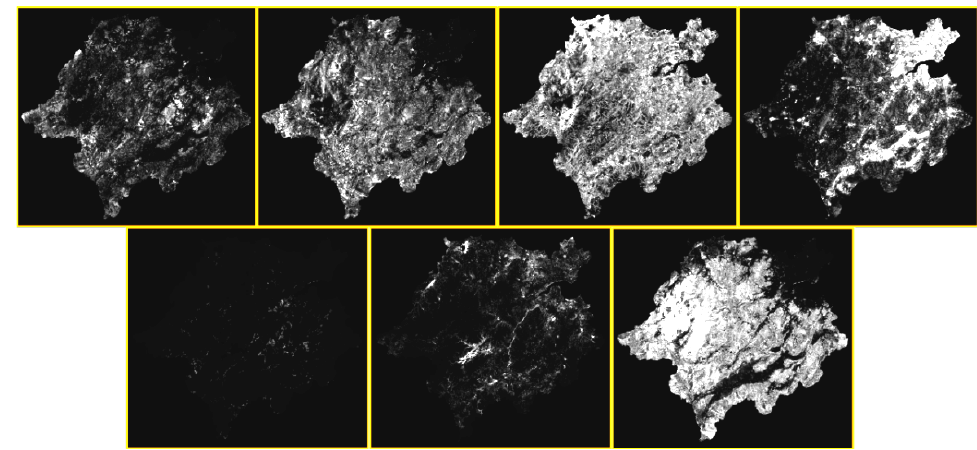
Figure 9. The development probabilities of various types of land, and the contribution of land ex- pansion in 2015–2018 (the clearer the white, the greater the contribution).